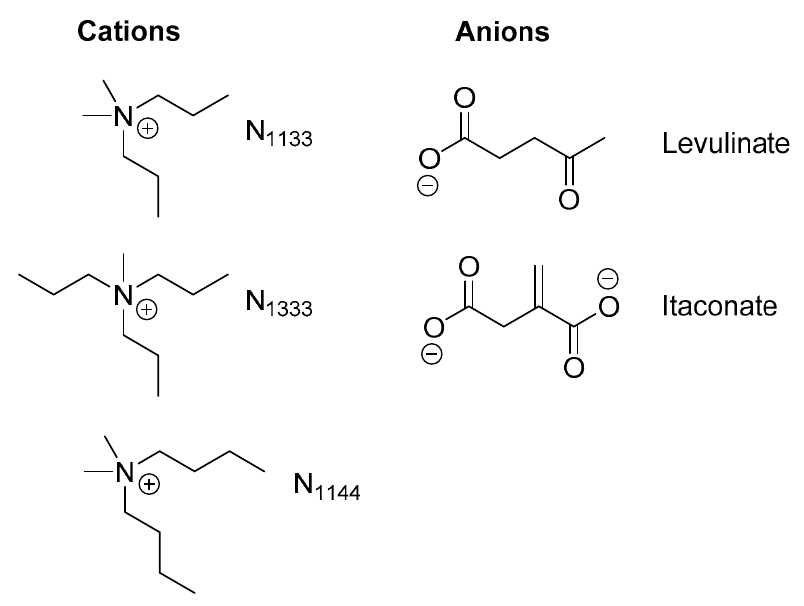
Figure 10. Structure of the levulinate and itaconate-based QAE used for cellulose dissolution [186]. Relevant examples of carboxylate-based QAEs as cellulose solvents are summarized in Table 2. Table 2. Examples of the solubility of cellulose in quaternary ammonium carboxylates. Cellulose Solvent